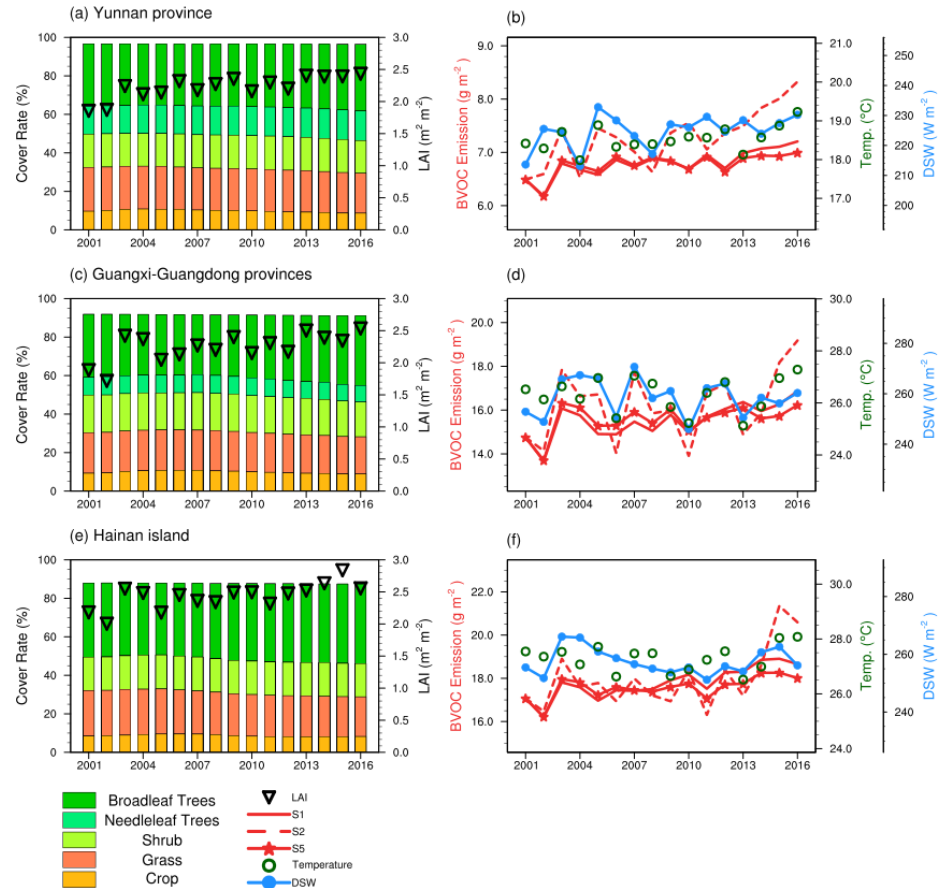
Figure 8. The annual changes of PFTs and the annual emission amount of BVOC and LAI in (a) southwestern China, (b) southern China and (c) Hainan island. The solid, dashed and marked lines represent the mean emission flux rate of total BVOC in S1, S2 and S5, respectively. Table 5. Comparison of isoprene and monoterpene emissions (Tg) in China with previous